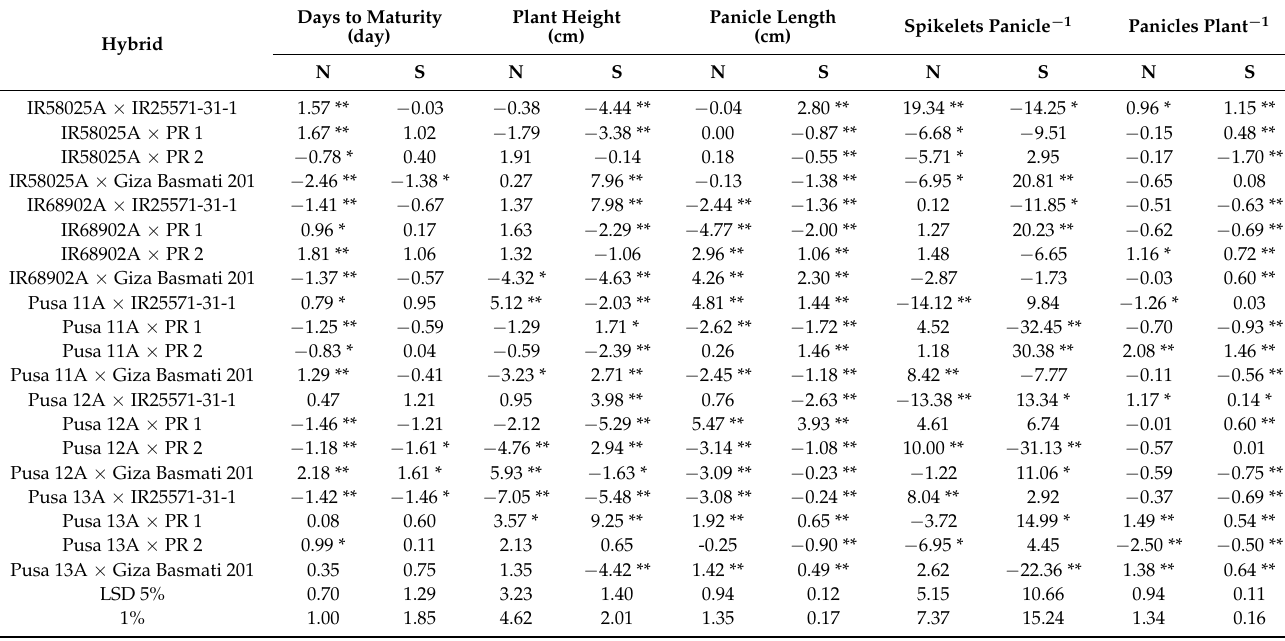
Table 4. Estimation of Specific Combining Ability (SCA) Effects of Hybrid Rice Combinations for 10 Yield Characteristics Under Normal and Water-Stress Conditions.